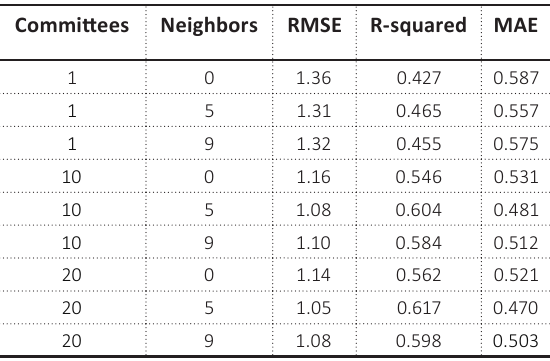
Table 7. Cubist resampling results across tuning parameters for 566 samples and 6 predictors